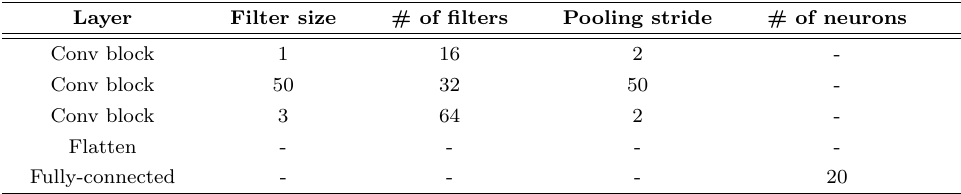
Table 4: CNN architecture of the XMEGA dataset.